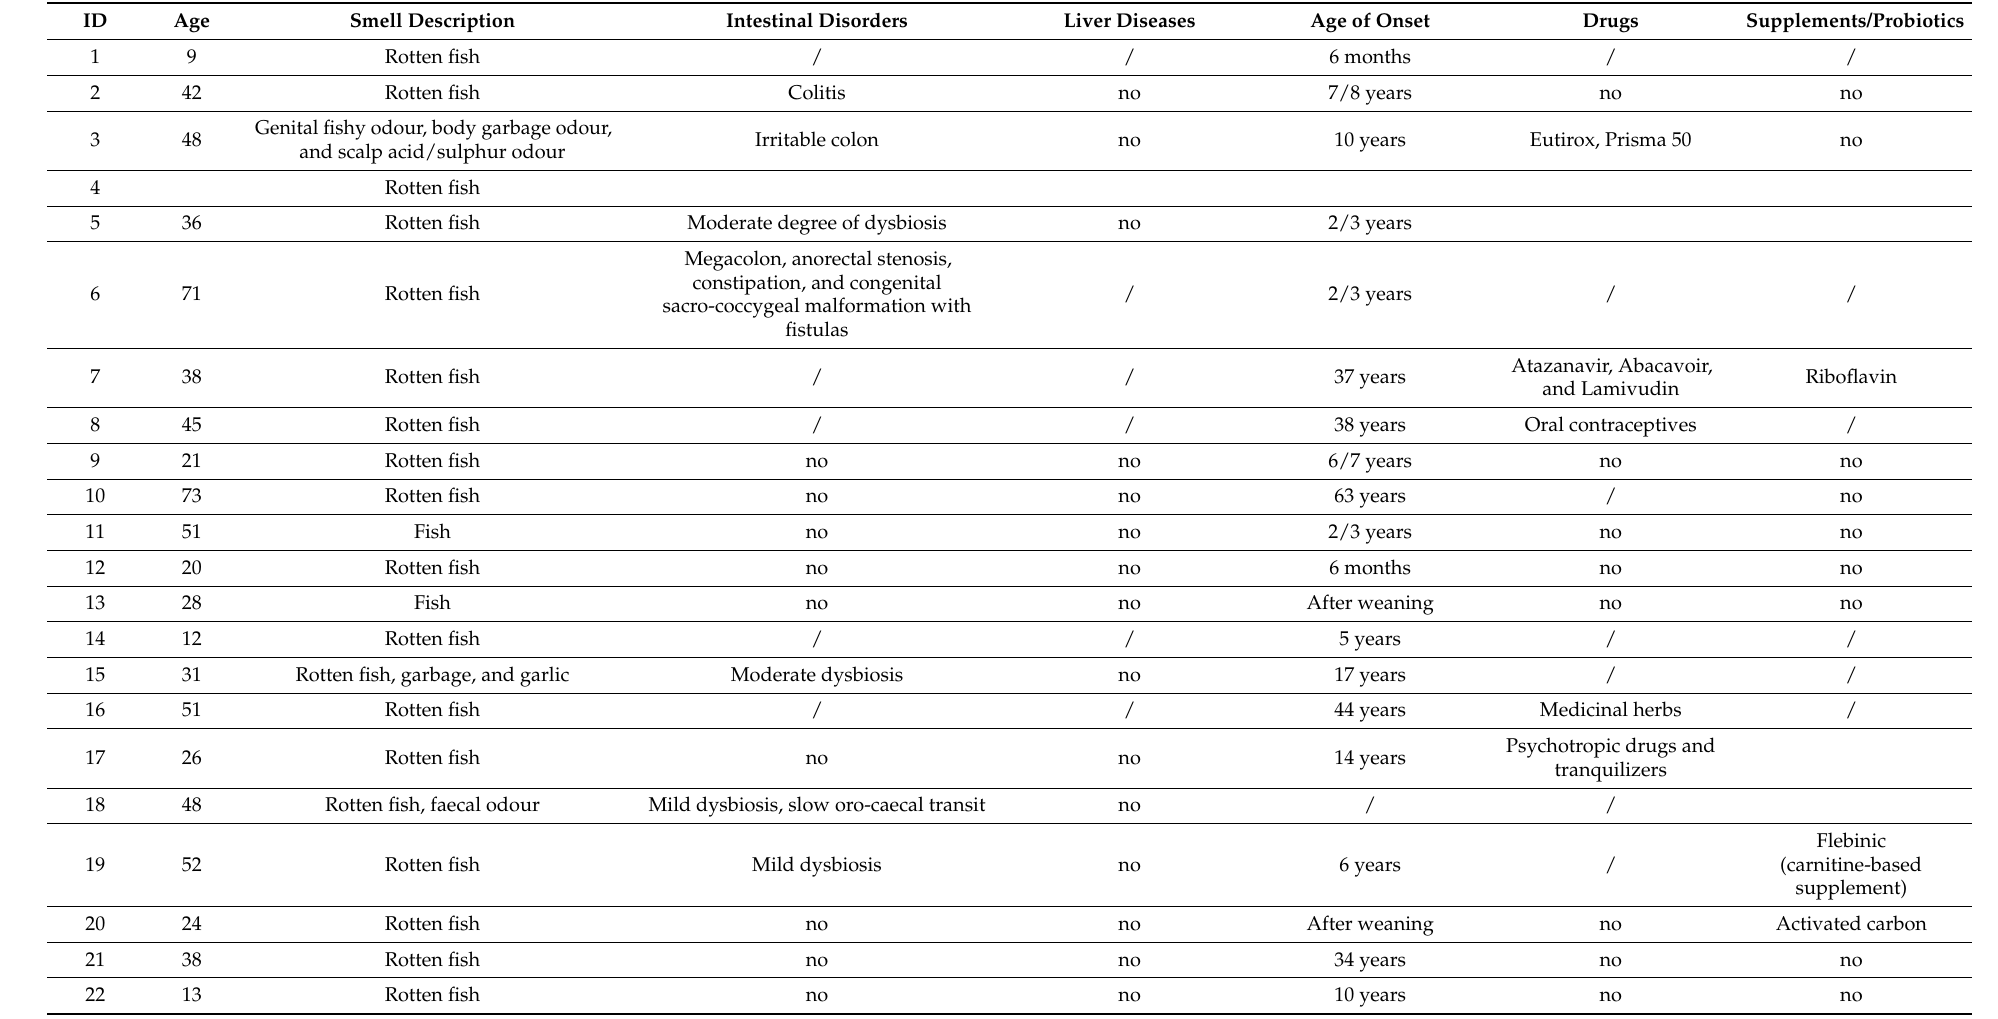
Table 6. Clinical features of the 26 TMAU patients involved in this study. Signs, symptoms, and pathological features listed are those most frequently observed in TMAU affected individuals, as well as several ones specific of particular